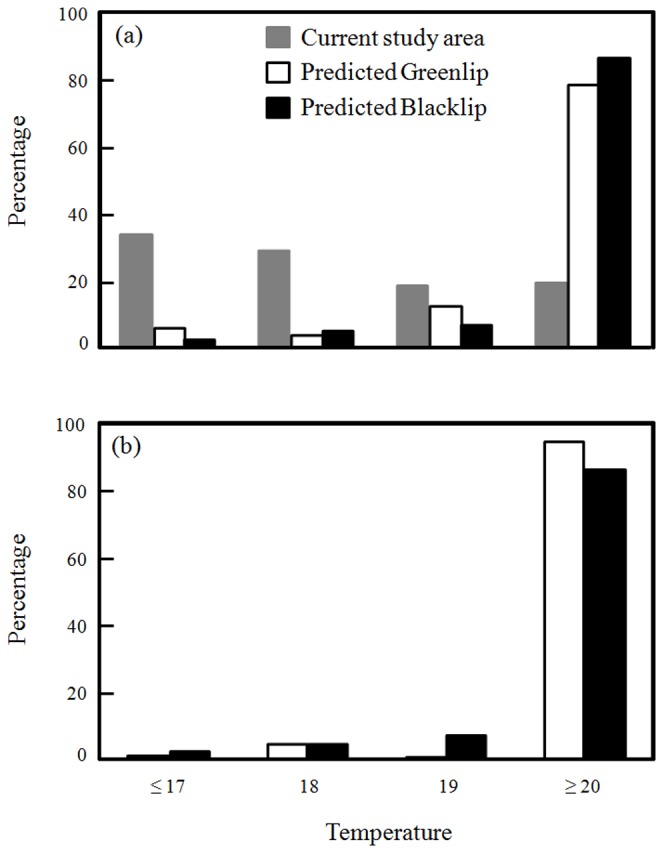
The percentage of South Australian waters at different mean-March temperatures.(a). Grey bars show current-day temperatures across the entire area, while the white and black bars show the percentage of the current distributions of greenlip (white bars) and blacklip abalone (black bars),at predicted temperatures for 2100 under the high-CO2 Reference scenario and (b) the percentage of predicted abalone distributions (based on SDMs using August SST) which would be at different March temperatures in 2100. The current day temperatures (grey bars) are the same for both (a) and (b). Also note for both (a) and (b) the increase percentage of the area at or above 20°C, meaning that these predicted distributions may not be realised.